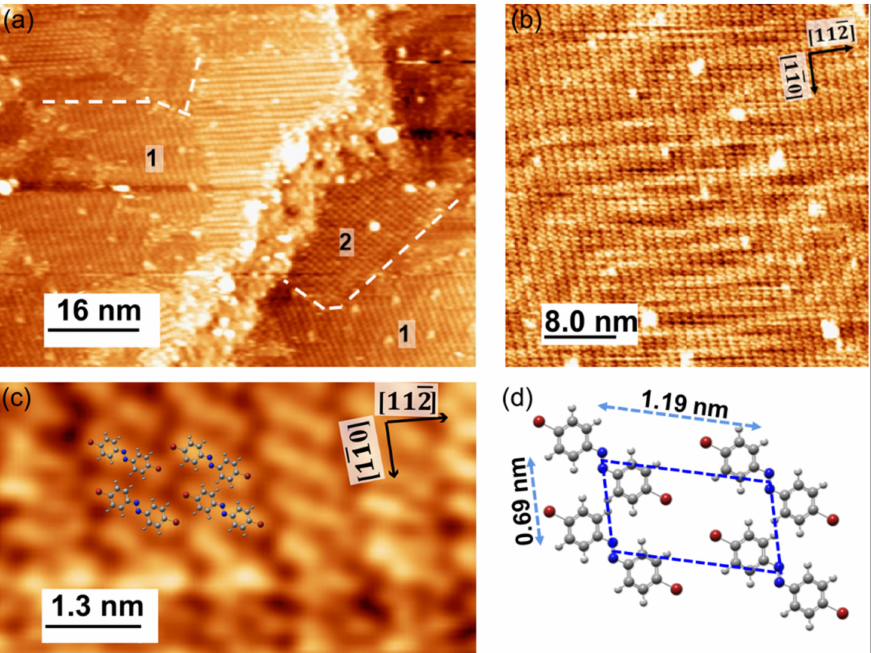
Figure 2. ( a ) STM constant-current image of Br-AB molecules on the Au(111) surface ( − 1.2 V, 0.3 nA, 80 × 51 nm 2 ); ( b ) Scan image of the Br-AB molecules with herringbone in the background ( − 1.2 V, 600 pA, 40 × 40 nm 2 ); ( c ) Close-up image of Br-AB molecules on Au(111). The proposed molecular self-assembly structural model is overlaid on the image, ( − 1.2 V, 600 pA, 7 × 4 nm 2 ); ( d ) Ball– stick model of the trans-isomer of the Br-AB molecule representing the arrangement as seen in ( c ). The red, grey, blue, and white balls correspond to the bromine, carbon, nitrogen, and hydrogen atoms,